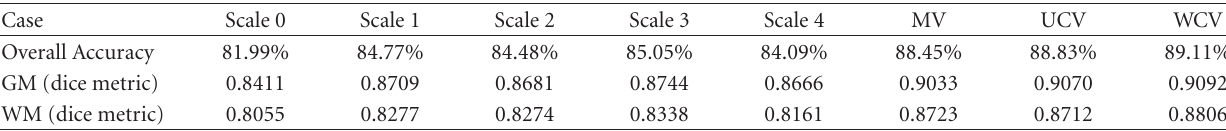
Figure 4: Performances comparison of brain under di ff erent cases: (a) original image, (b) result at scale 0, (c) result at scale 1, (d) result at scale 2, (e) result at scale 3, (f) result at scale 4, (g) result of majority voting, (h) result of unweighted confidence voting, (i) result of weighted confidence voting, and (j) ground truth. Table 1: Quantitative evaluation for brain MR-data.